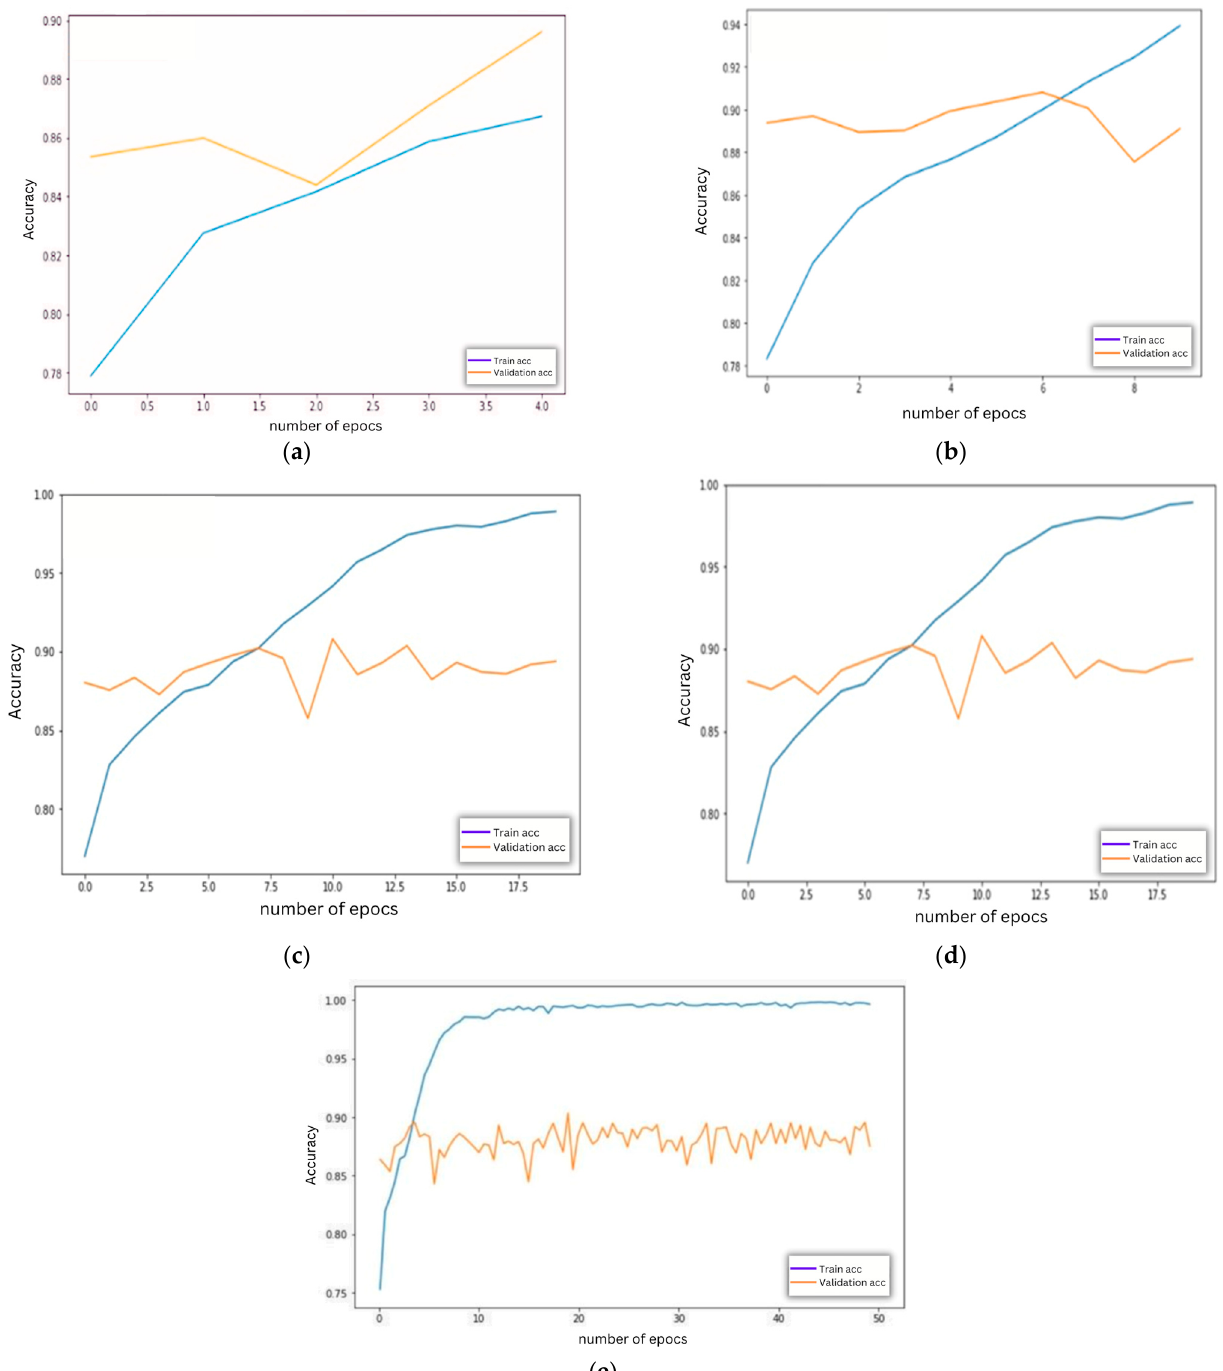
Figure 6. Evaluating the proposed CNN model’s accuracy. ( a ) has epochs = 3, ( b ) has epochs = 5, ( c ) has epochs = 10, ( d ) has epochs = 20, ( e ) has epoch = 50.